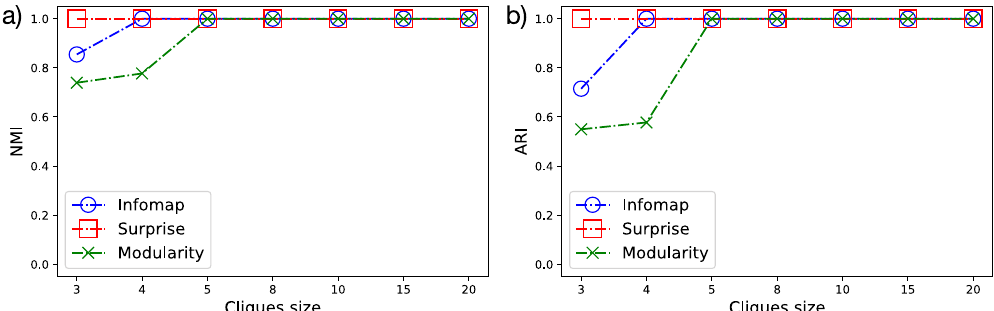
Fig. 2 Performance of community detection algorithms on ‘ homogeneous ’ rings of cliques. For each con fi guration, twenty cliques of the same size (i.e. K K K K K K K 3 , 4 , 5 , 8 , 10 , 15 , 20 ) have been considered. Panels a , b respectively show the Normalized Mutual Information (NMI) and the Adjusted Rand Index (ARI) as a function of the number of cliques. While surprise always recovers the planted partition, modularity misses the partitions induced by K 3 and K 4 and Infomap misses the partition induced by K 3 — a result that may be a consequence of the resolution limit, known to affect the last two algorithms.